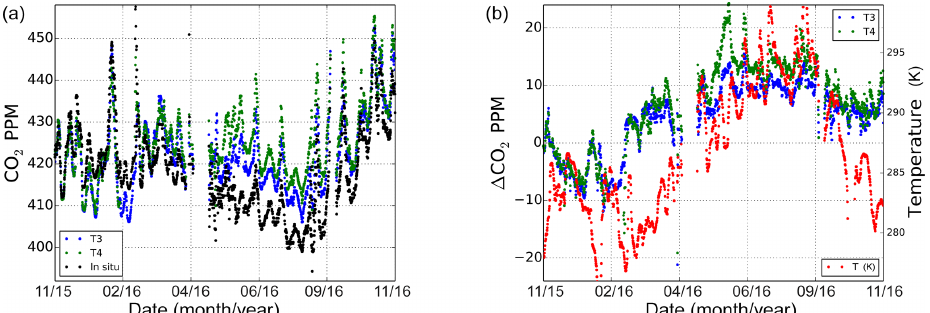
Figure 4. Four-day median measured and observed CO 2 over all chords for each transceiver. Panel (a) illustrates the median value for each transceiver and the combined in situ measurement median values. Panel (b) shows the differences between the median transceiver values and the median in situ measurements. The additional red trace in (b) denotes the 4d median near-surface air temperature and provides a visual aid to assess the correlation between the atmospheric state and the differences between column and point source observations. T3 denotes transceiver serial no. 3 located in the lower left-hand corner of Fig. 1 at the CIT tower, and T4 indicates transceiver serial no. 4 located in the lower right-hand corner at UPMC.